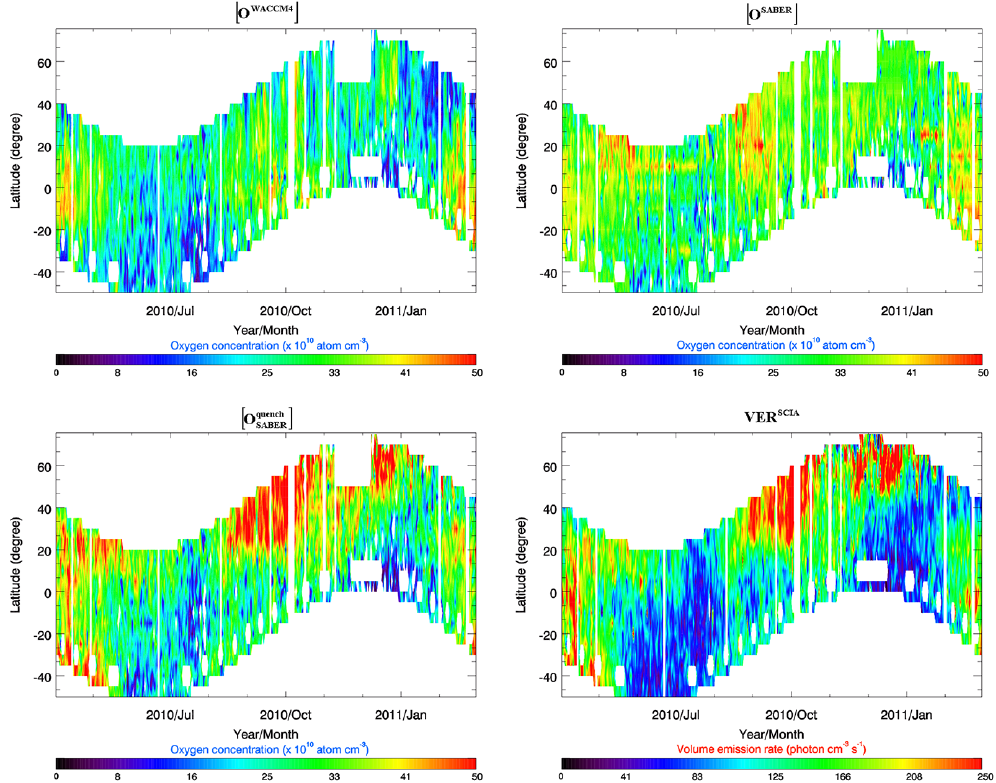
Figure 14. Seasonal variations of daily and vertically averaged (between 85 and 100km) atomic oxygen fields from April 2010 to March 2011: [O WACCM4 ] (top left), [O SABER ] (top right) and [O quench ] (bottom left). The bottom right panel shows daily and vertically SABER integrated (also from 85 to 100km) SCIAMACHY volume emission